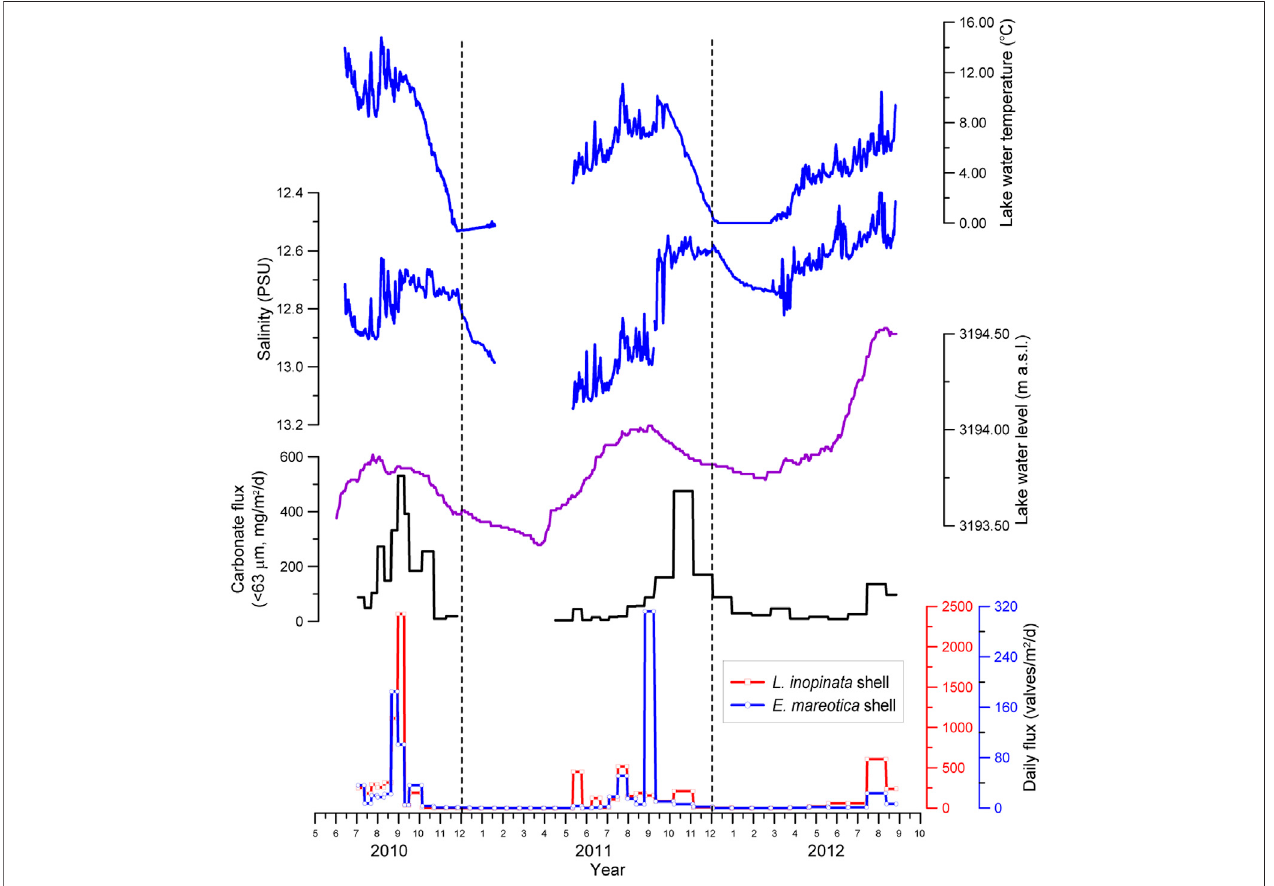
FIGURE2| Variationsinabundancefortwospeciesofadultostracodshells( L.inopinata and E.mareotica )andcarbonate fl uxfromJuly2010toSeptember 2012, along with water temperature, salinity, and water level of Lake Qinghai.